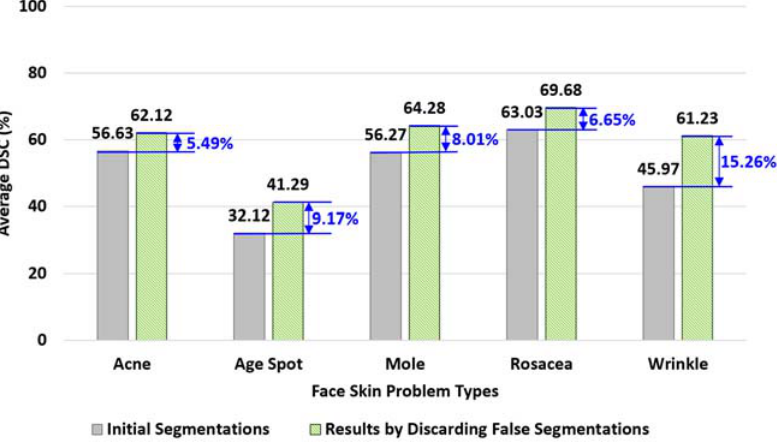
Figure 18. Comparing performances of segmentations with ‐ and without discarding false segmen ‐